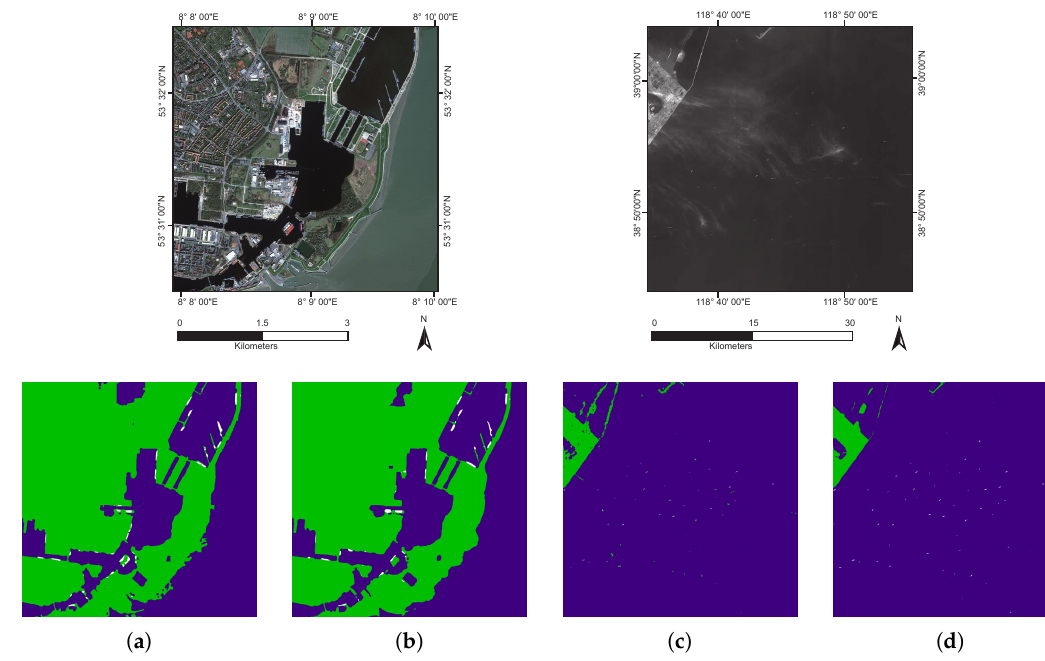
Figure 8. Semantic labeling results on Google Map images ( a , b ) and GaoFen-1 images ( c , d ). The images are arranged as original ( top ), proposed method without multi-scale ( a , c ) and proposed method with multi-scale ( b , d ). Here sea, land and ship are labeled as blue, green and white, respectively.